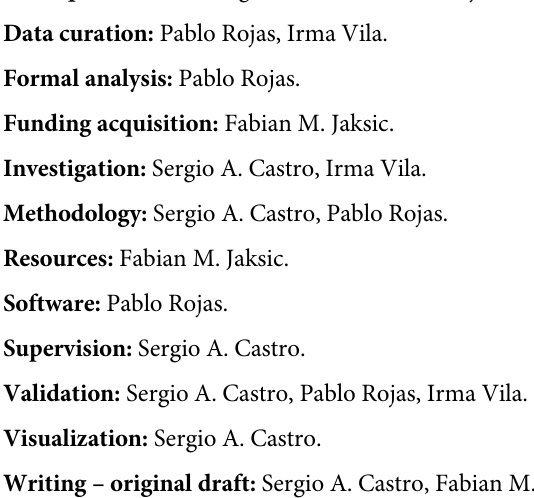
S1 Table. Data matrix with freshwater fish species, origin, status, and occurrence at 20 basins in continental Chile. For each basin the occurrence of native and exotic species is indi- cated by 1 = Present; 0 = Absent; 1/0 = Extirpated. The conservation status of native species is indicated as: CR = Critically endangered; EN = Endangered; VU = Vulnerable; NT = Near threatened; LC = Least concern;— = Not evaluated (MMA 2021). For native and exotic species, brackets are ordered as: [historical presence, current presence, presence in Future 1 assem- blage], presence in Future 2 assemblage]. S2 Table. Functional traits used to describe fish functional diversity. Native and exotic fish traits and functional roles from Rojas et al . (2020) (https://doi.org/10.1016/j.gecco.2020.e01355). S3 Table. Native and exotic fish traits and functional roles.